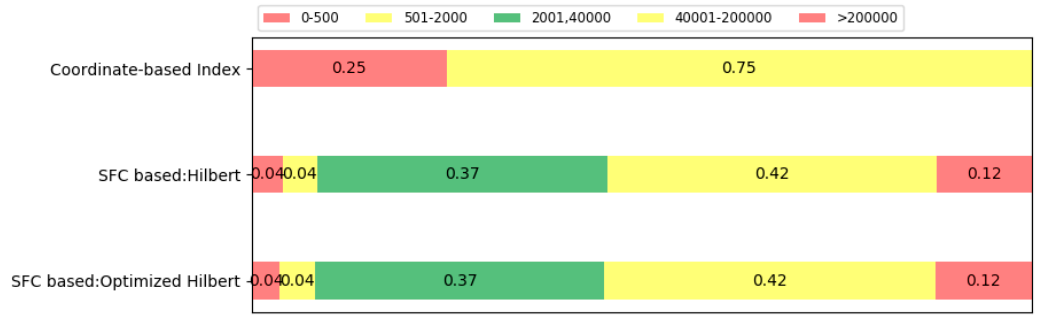
Figure 15. Proportion of SCAN operations of different sizes with ScienceGeoIndex.